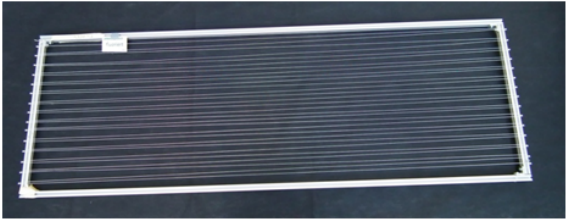
Figure 6. Yarn preparation as used for the (oxy-)fluorination treatment.